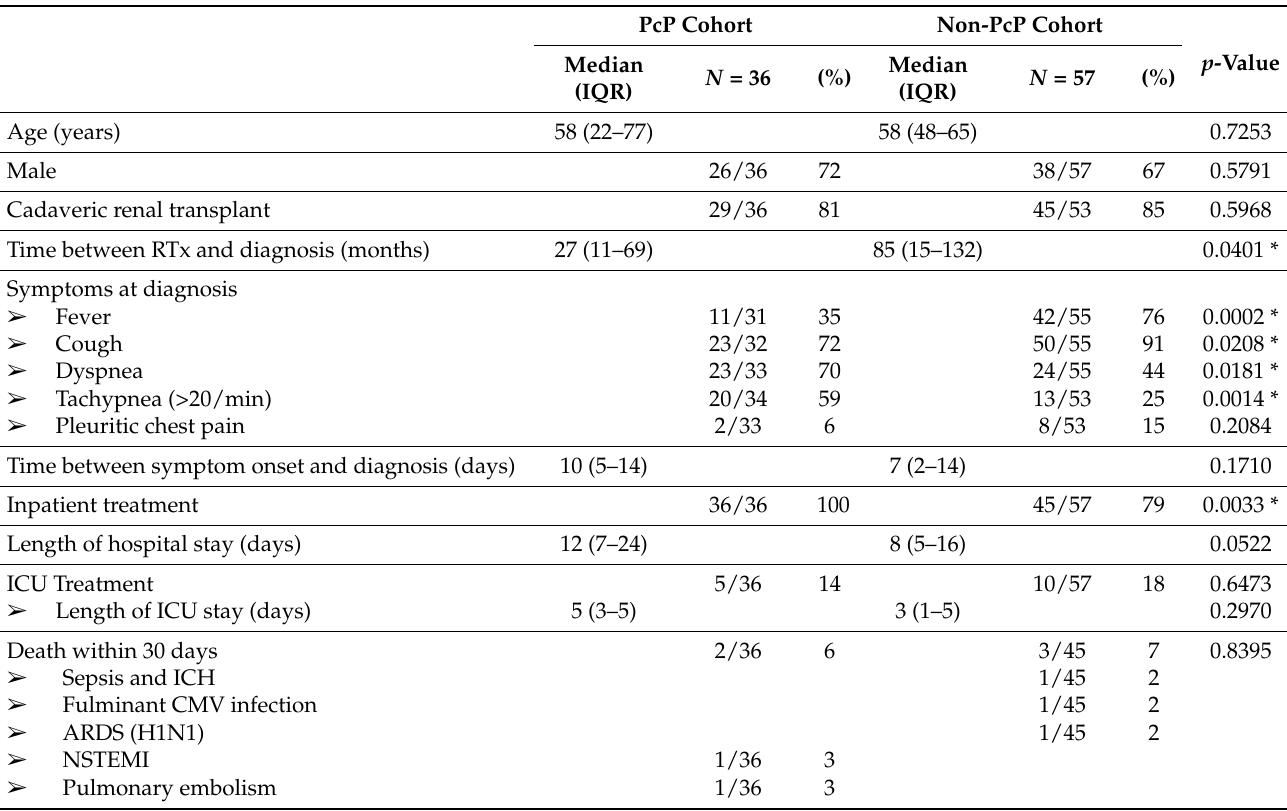
Table 1. Demographics and clinical characteristics of PcP and non-PcP in renal transplant recipients